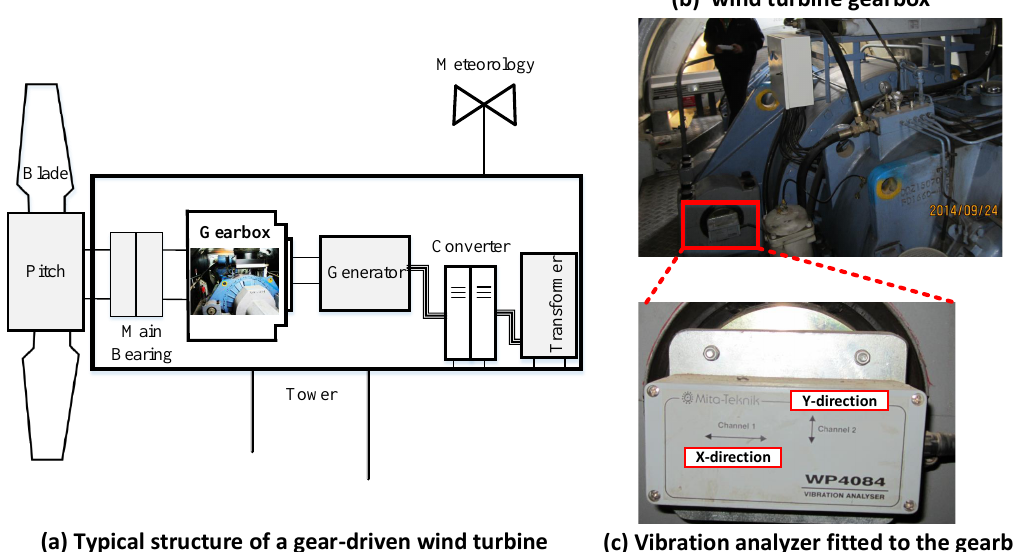
Figure 1. Wind turbine gearbox vibration monitoring with SCADA systems.